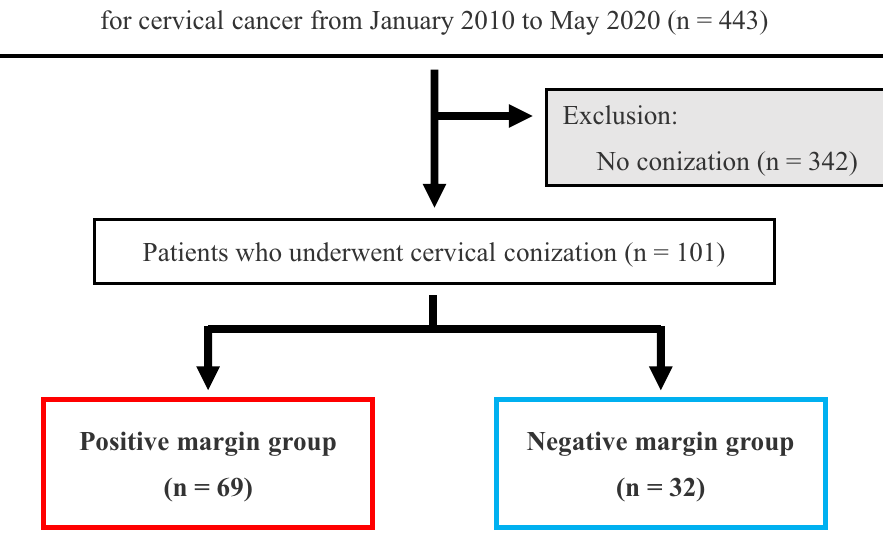
Figure 1. Flowchart of patient selection. Of the 443 patients who underwent radical surgery, including pelvic lymph node dissection for cervical cancer from January 2010 to May 2020, we excluded 342 patients without conization and included 101 patients with conization. Of the 101 patients, 69 had positive margins at conization and 32 had negative